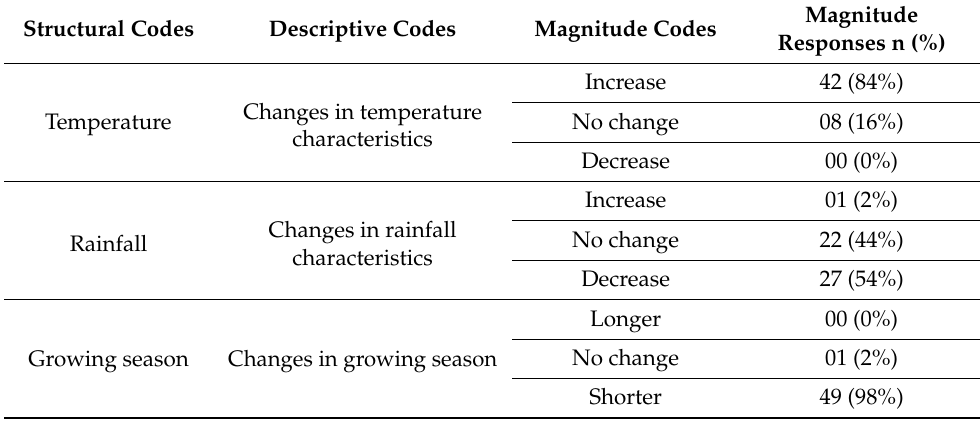
Table 2. Participant perceptions in relation to key climate change metrics of interest and adaptive responses ( n =